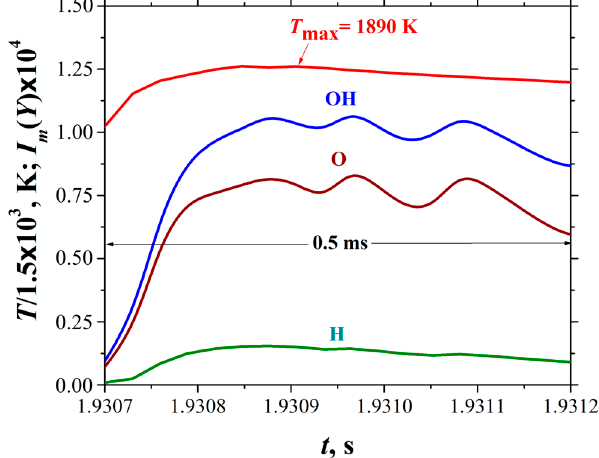
Figure 11. A fragment of calculated time histories of the maximum gas temperature, T m , and the integral mass fractions of active species OH, O, and H at the forced ignition and combustion of the n-dodecane droplet with D 0 = 2.8 mm and L = 0.55 cm in air at NPT conditions.